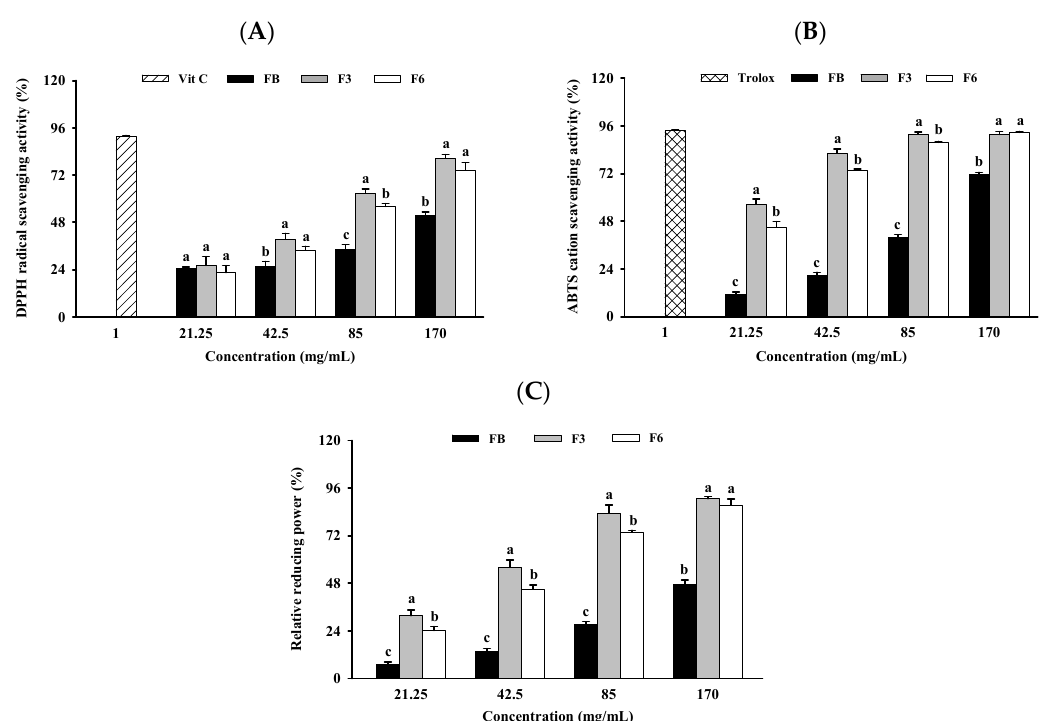
Figure 1. Effect of FB, F3, and F6 on ( A ) DPPH, ( B ) ABTS + radical scavenging activity, and ( C ) relative reducing power. Data are expressed as mean ± SD ( n = 3). Duncan’s multiple range tests were performed, and different superscripts (a,b,c) assigned to the same concentration indicate significant differences ( p < 0.05). FB: fish bone; F3: fish bone fermented with Monascus purpureus for 3 days; F6: fish bone fermented with Monascus purpureus for 6 days.